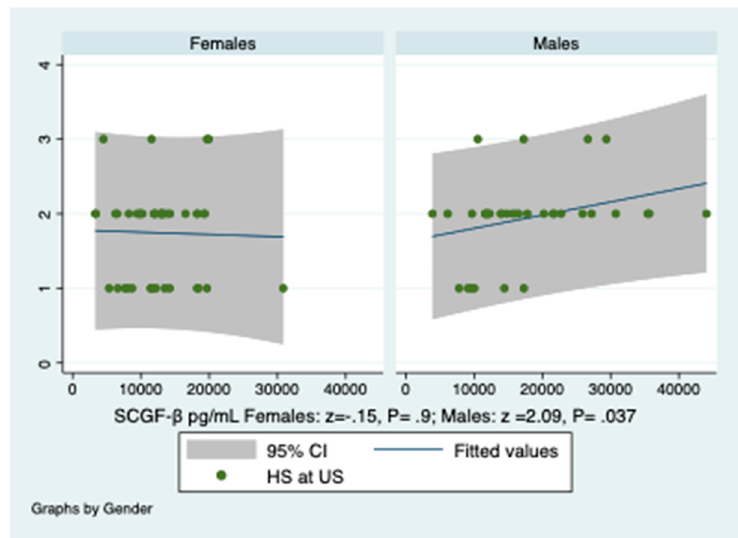
Figure 3. Prediction of the severity of hepatic steatosis at ultrasonography by SCGF- β levels. Y -axis reports the severity of hepatic steatosis. There is a gender-related difference of SCGF- β levels in predicting the severity of hepatic steatosis at ultrasonography, HS at US, expressed in grades (1–3). Ordered probit regression. A linear regression analysis was